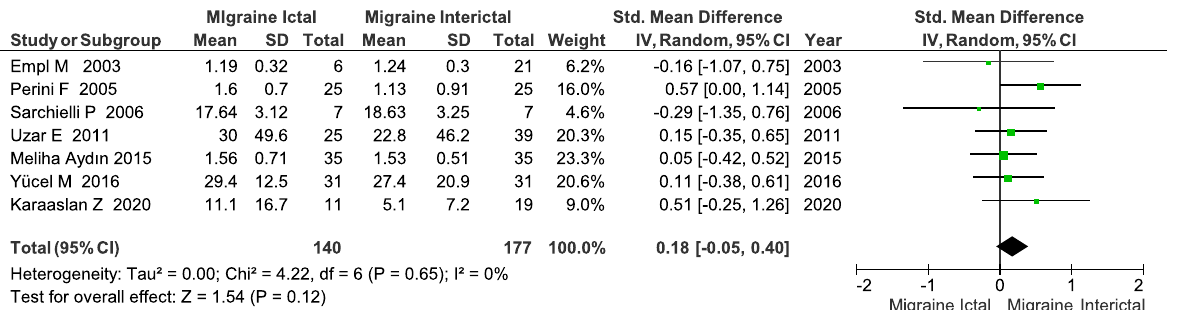
Fig. 4 Forest plot of IL-1β, IL-6 and TNF-α levels in patients with migraine in the ictal stage compared to interictally. Abbreviations: IL, interleukin; IV, inverse variance; I 2 , measure of heterogeneity; SD, standard deviation